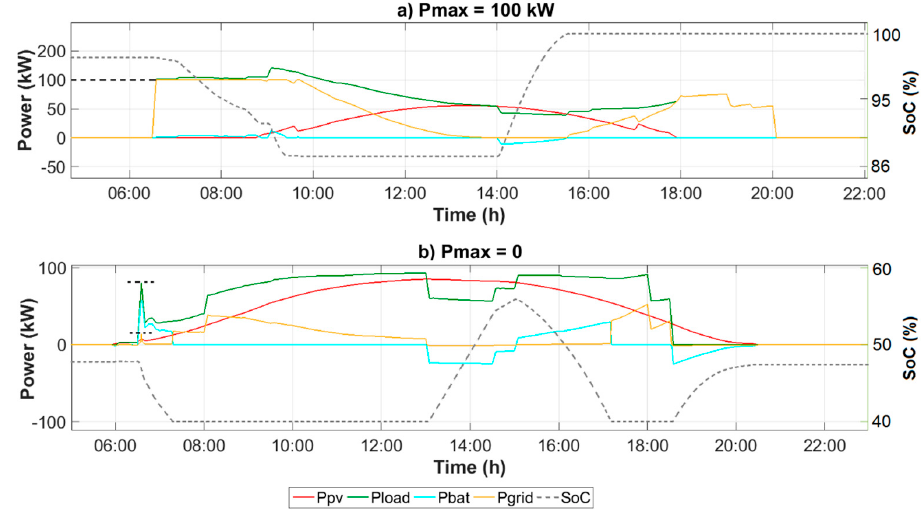
Figure 9. Daily electricity flows in office building with demand-side management: ( a ) typical winter day; and ( b ) typical summer day.